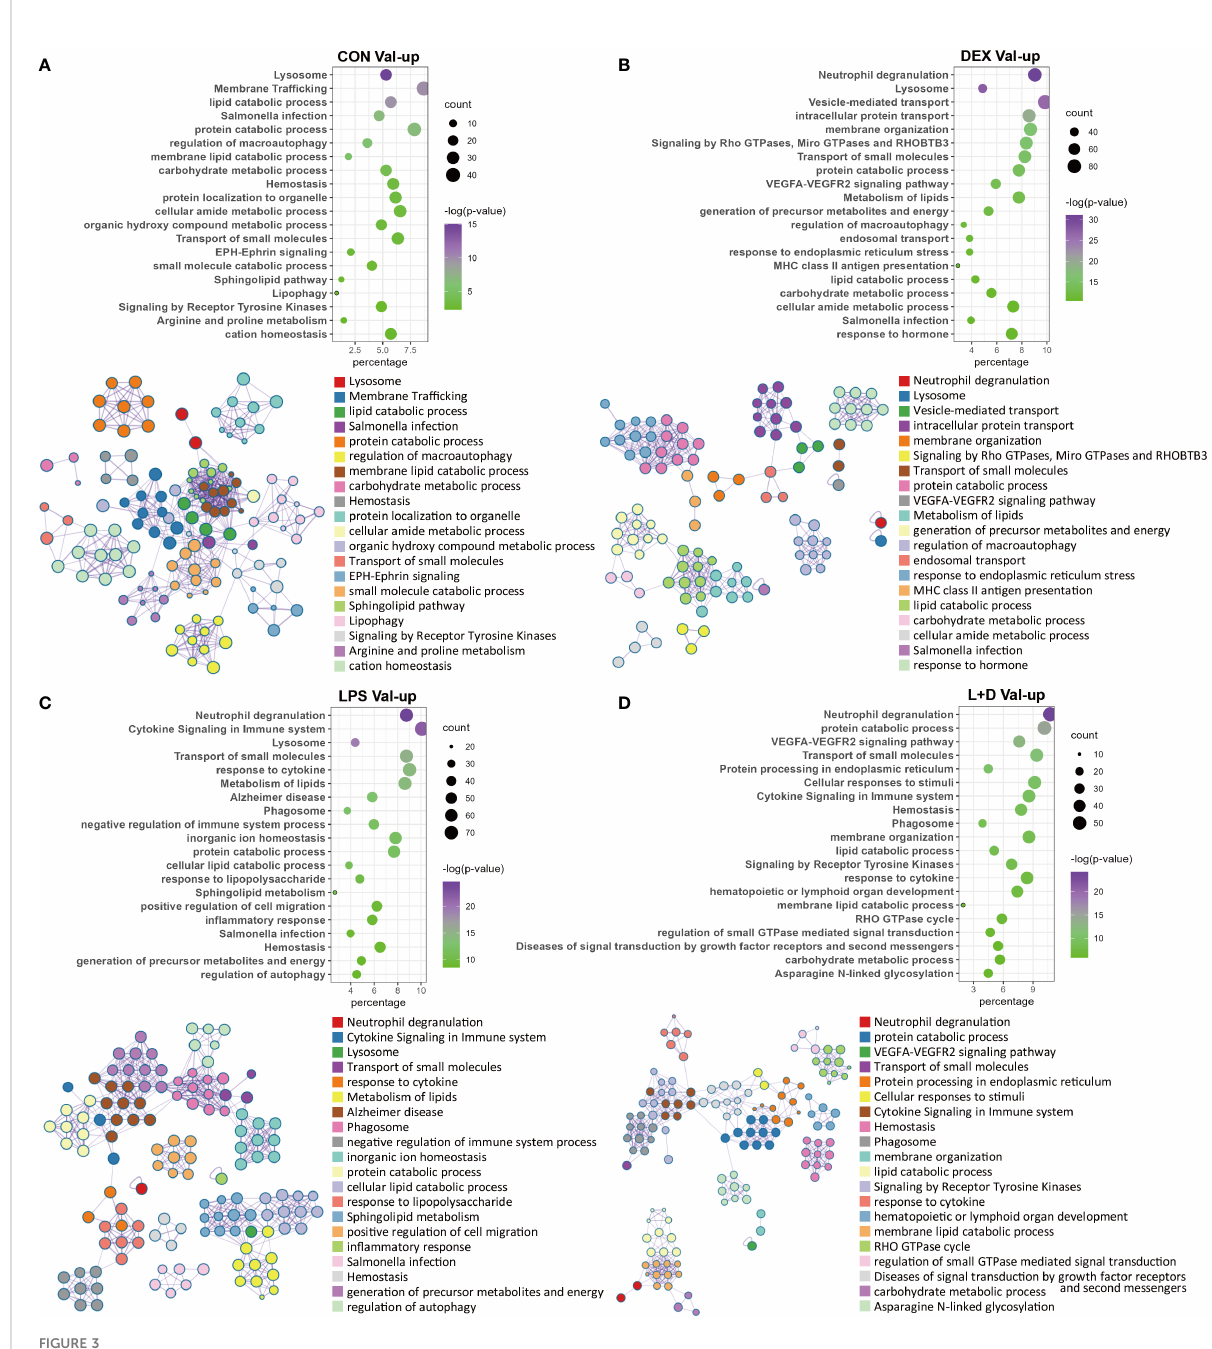
FIGURE 3 Enrichment analysis of Val-up genes in each treatment group. (A) Functional terms enriched for Val-up genes in CON group. (B) Functional terms enriched for Val-up genes in DEX group. (C) Functional terms enriched for Val-up genes in LPS group. (D) Functional terms enriched for Val-up genes in LPS+DEX group. Enrichment analysis was performed using the Metascape. Bubble plots illustrate signi fi cance and gene counts of top enriched terms, where purple indicates higher signi fi cance and green indicates lower signi fi cance and bubble size is positively correlated with gene counts. Networks illustrate the relationship between terms, where each node represents one functional term and terms with Kappa similarities above 0.3 are connected by edges. Each term cluster is labeled and represented by its most signi fi cant member and all members in the same term cluster are indicated by the same